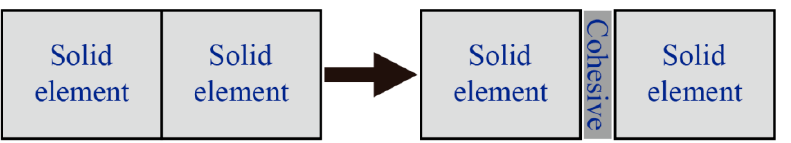
Figure 1. Schematic diagram of a cohesive element with 0 thickness embedded between solid ele- ments.